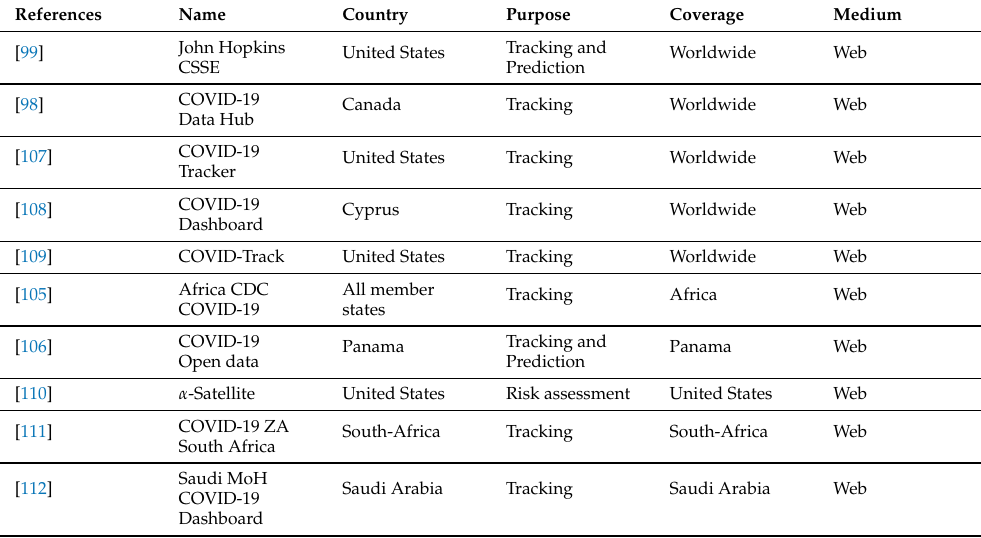
Table 3. A summary of open data dashboards for COVID-19 tracking and